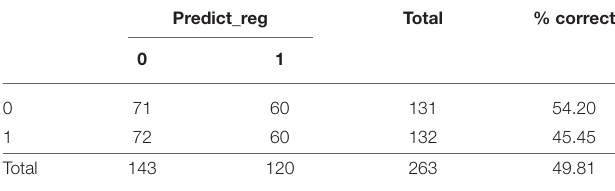
TABLE 8 | Logistic regression confusion matrix (Classification